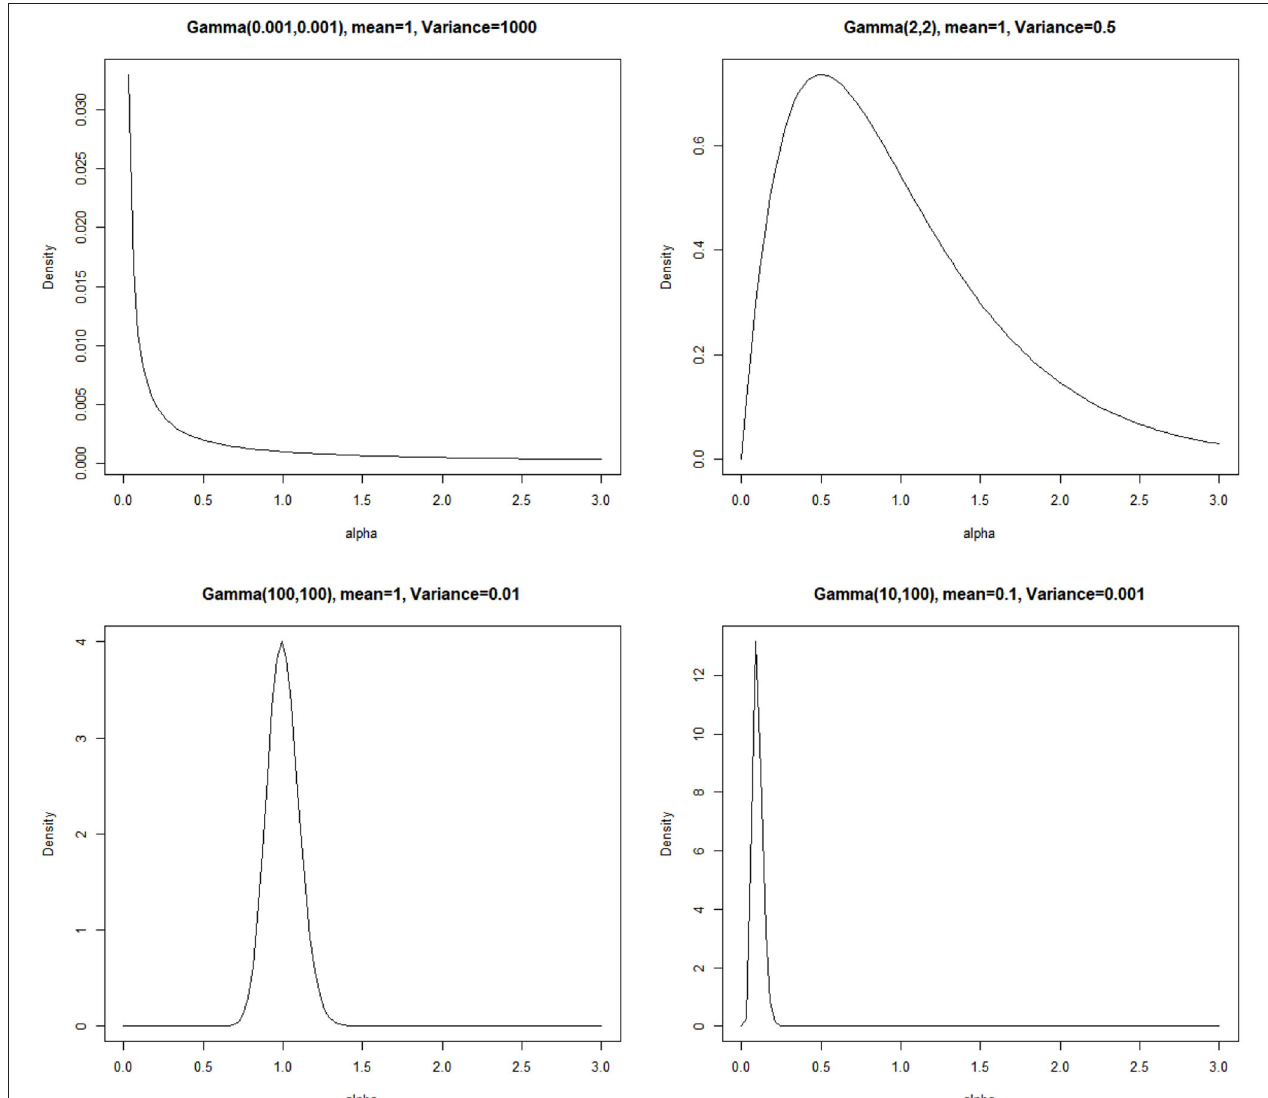
FIGURE 1 | Density curves for the four precision parameter priors used in the simulation